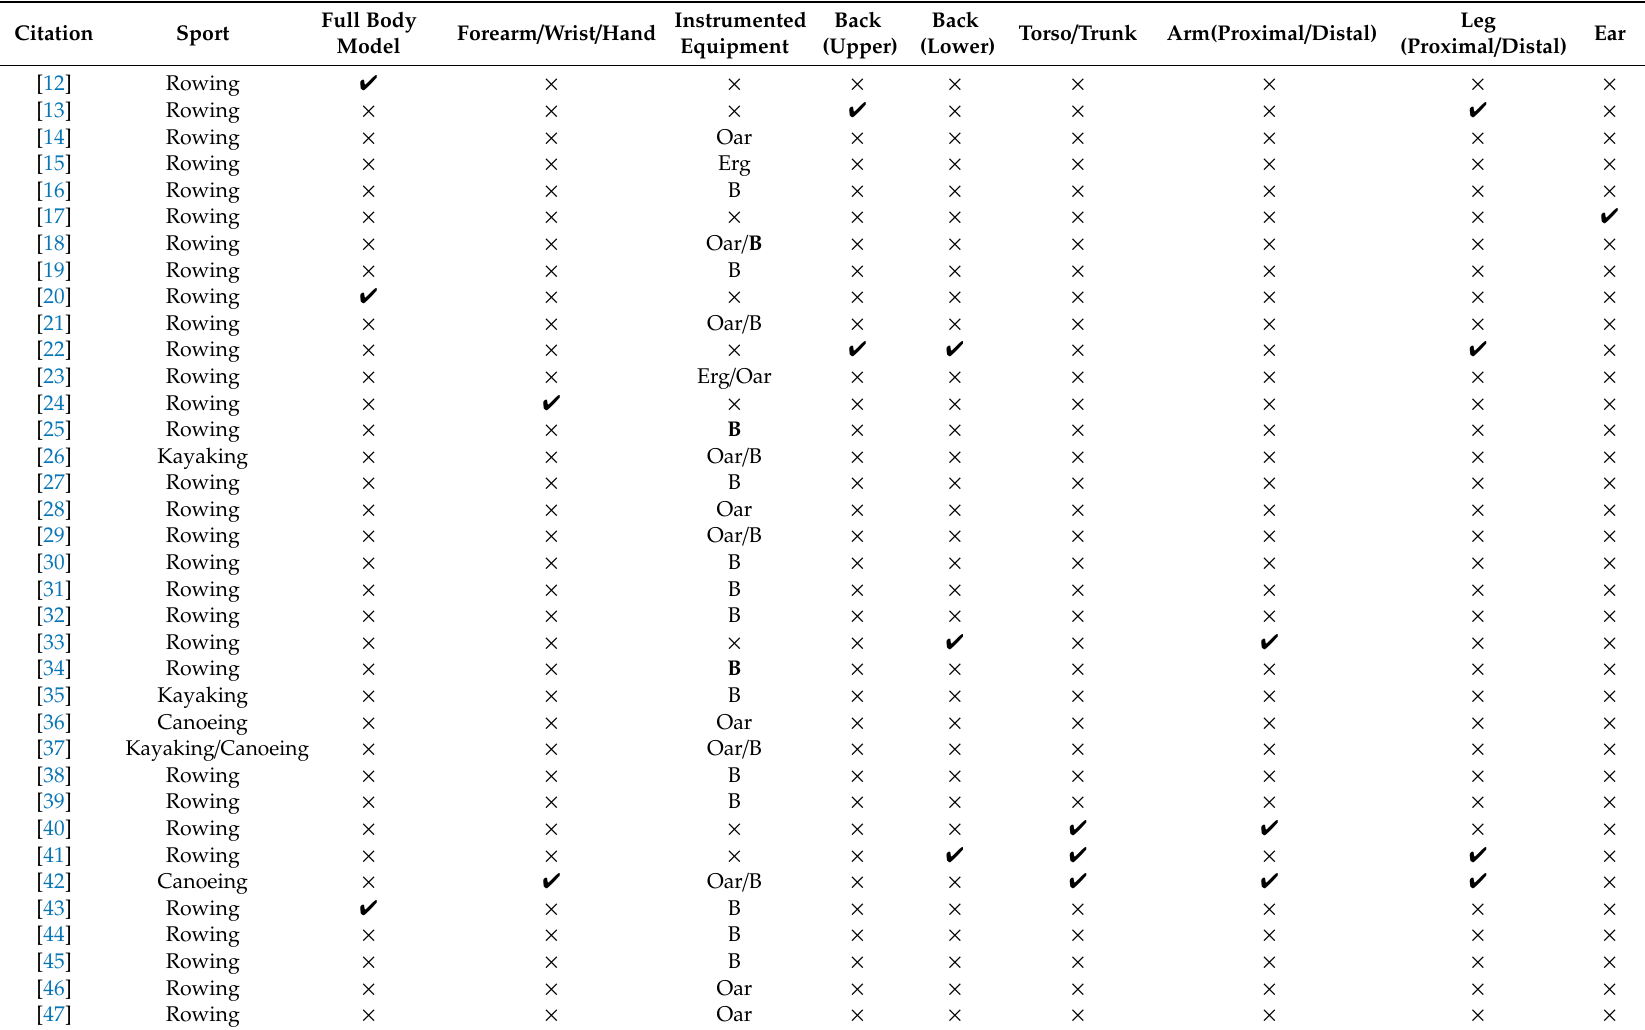
Table 5. Sensor placement, Erg (Ergometer); B